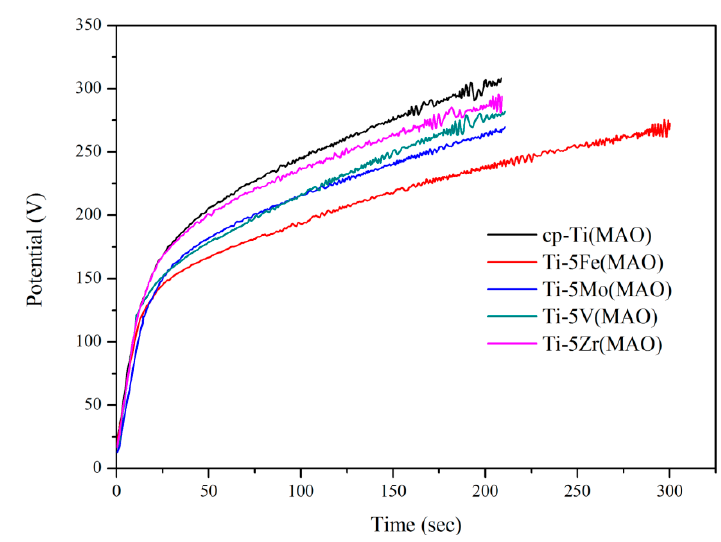
Figure 1. Potential vs. time curves of cp-Ti and Ti alloys during a micro-arc oxidized (MAO) process.